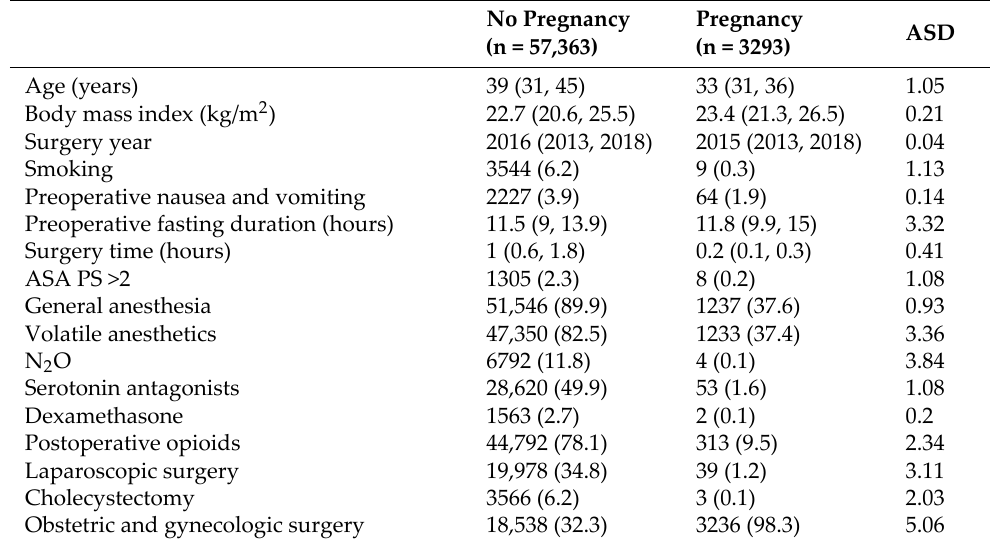
Figure 1. Flow chart. Table 1. Characteristics of PONV risk factors and covariates. Values are numbers (percentages) or medians (interquartile ranges).